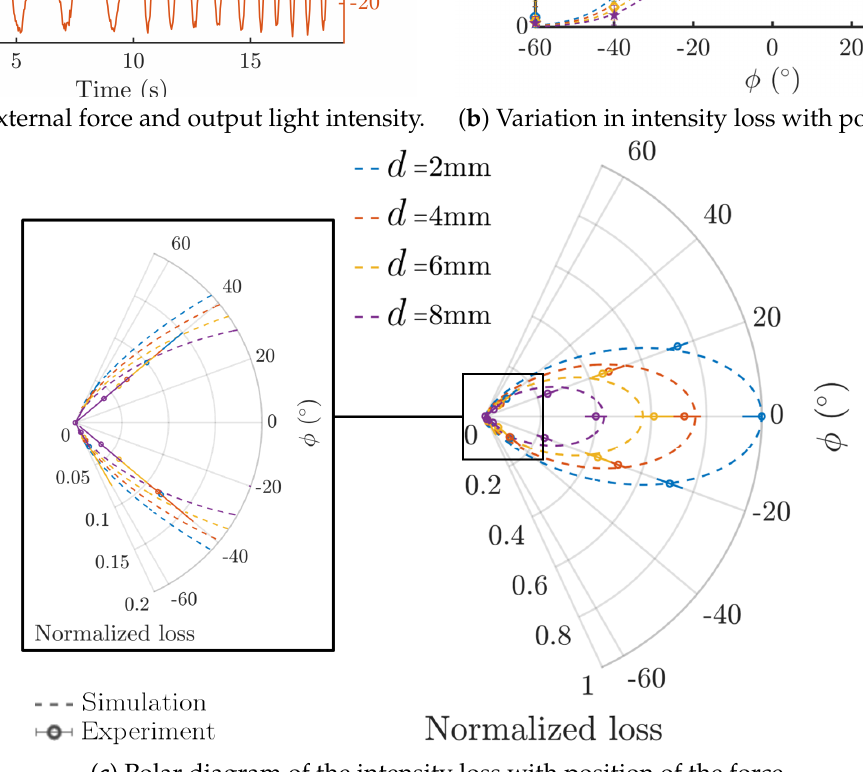
Figure 10. ( a ) Sensor response to 1 N concentrated force with frequencies 0.5, 1.0 and 1.5 Hz applied to the point (2 mm, 0 ◦ ), and ( b ) comparison of the trends of change in the intensity loss of Fiber-1 with 1 N external force at various positions (Cartesian diagram), ( c ) comparison of the trends of change in the intensity loss of Fiber-1 with 1 N external force at various positions (polar